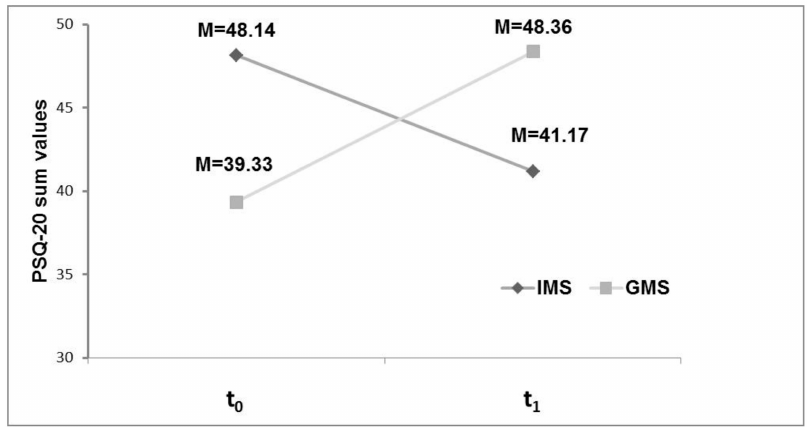
Figure 2. Perceived stress of tandem participants before and after the tandem program. M = mean values for PSQ-20 sum-score values at the two measurement time points, t 0 and t 1 , for the two groups, IMS and